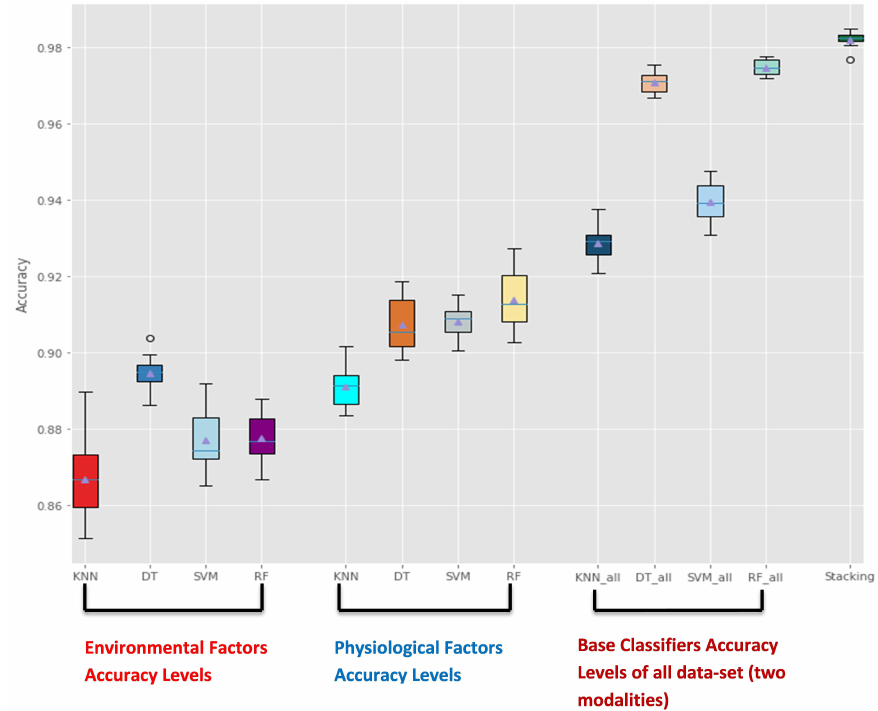
Figure 15. Accuracy Levels Comparison between Base classifiers Based on only Environmental, Physiological factors and those based on entire data-set with Stacking Ensemble Method Accuracy.